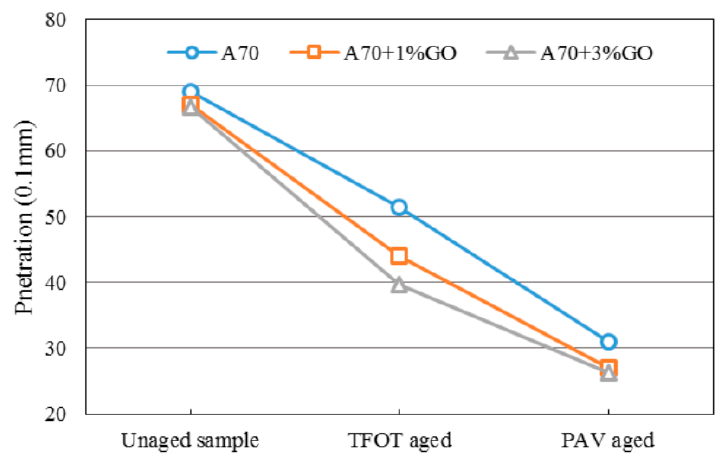
Figure 5. Penetration of GO-modified 70A and its matrix before and after aging.